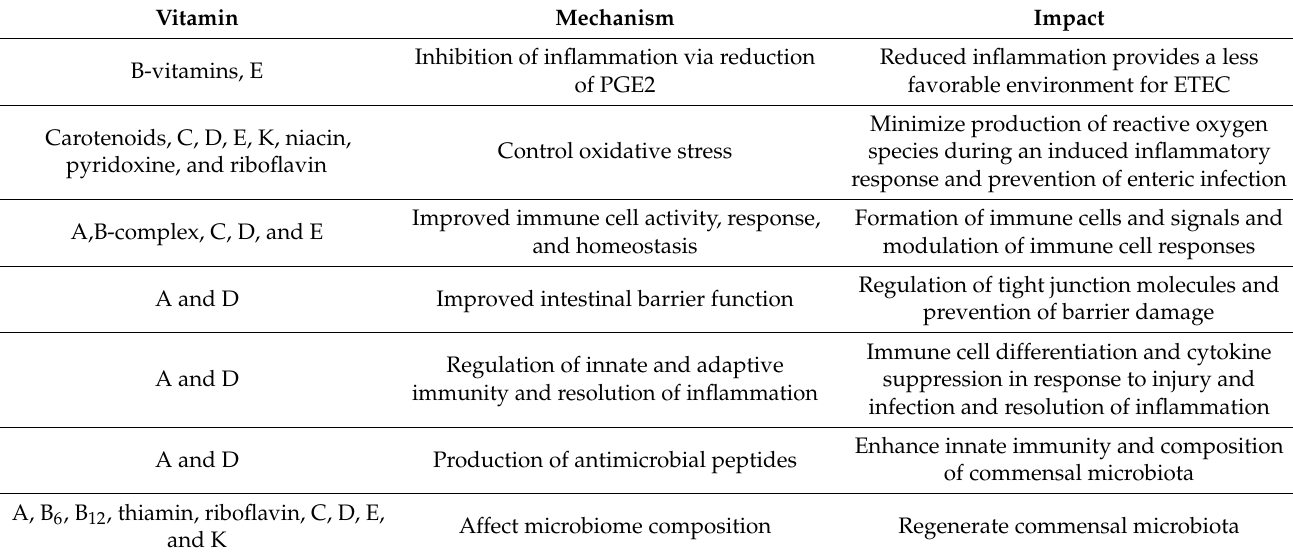
Table 16. Summary of the potential role of vitamins in inhibiting enteric infections in pigs (adapted from [368]). Vitamin Mechanism Impact Inhibition of inflammation via reduction Reduced inflammation provides a less B-vitamins, E of PGE2 favorable environment for